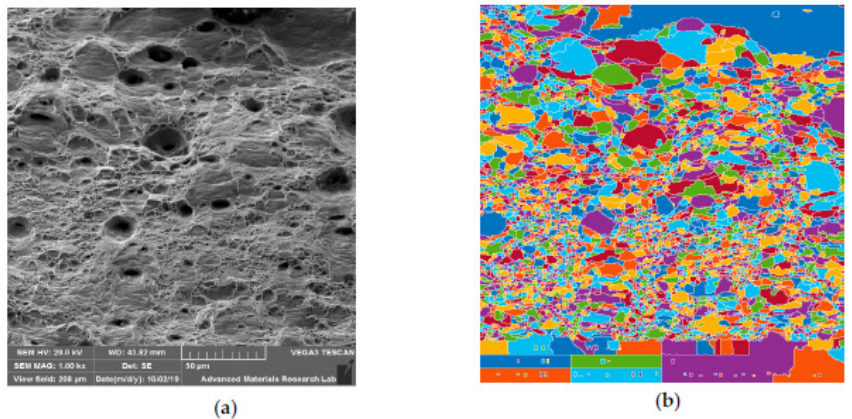
Figure 18. Dimple size analysis for CT specimen: ( a ) SEM image at 1000 × ; ( b ) Processed image. Table 6. Dimple sizes for UT, CT, and HT specimen.